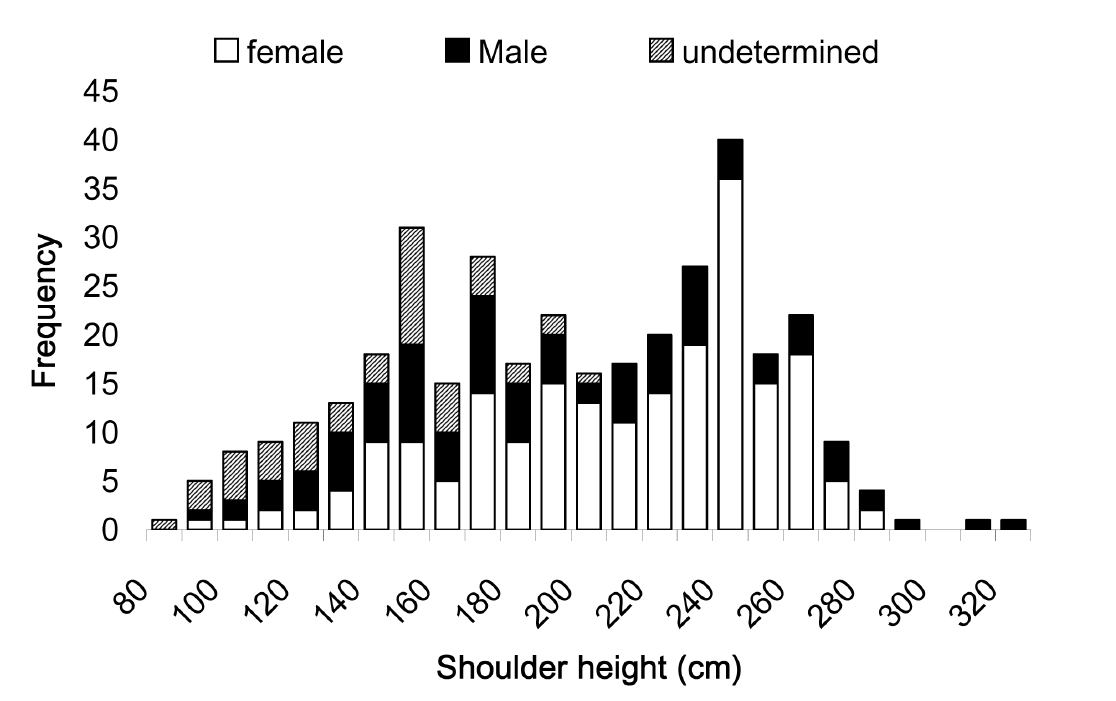
Fig 5. Frequency distribution of shoulder height for 352 identified elephants in Zakouma National Park, Chad (the mean of all measured individuals was 194.2 ± 2.6 cm, and the median was 195.2 cm). Striped bars indicate newborn and young individuals; black bars indicate sub-adult and adult males; white bars indicate sub-adult and adult